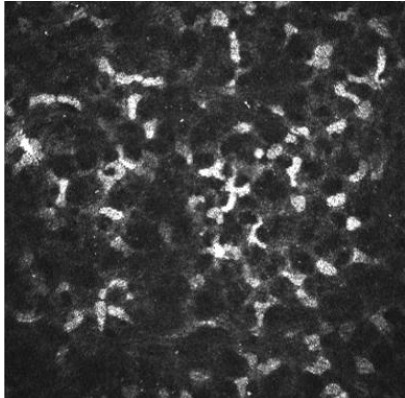
Figure 3. Corneal stroma of a human cornea observed with the confocal corneal microscopy HRTII.